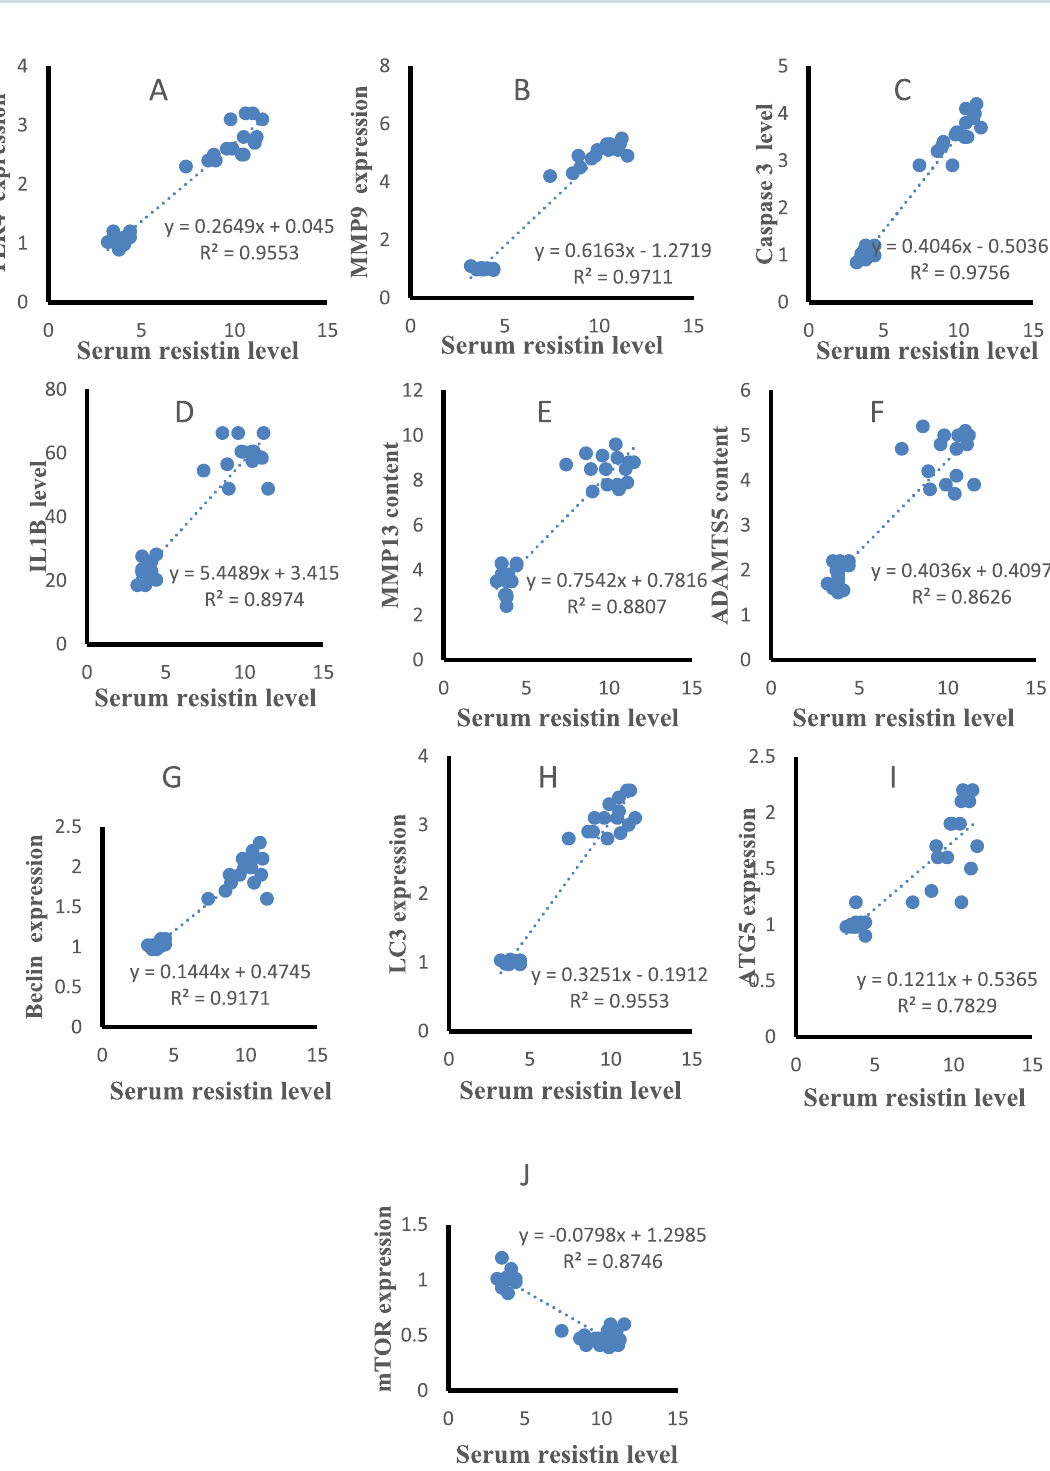
Figure 5. Correlations of serum resistin levels with other studied parameters in control and HFD